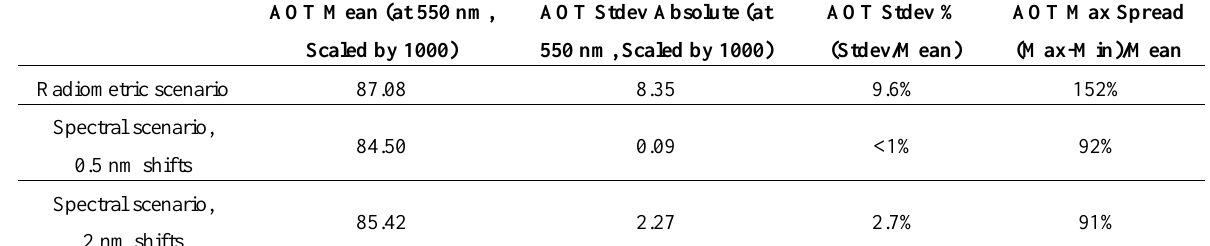
Table 3. Statistical description of the aerosol optical thickness retrieval.